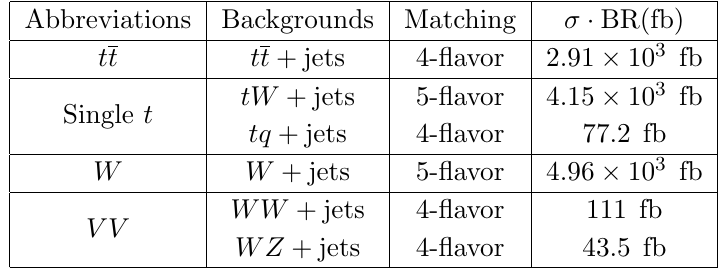
Table 4 . The summary of the SM backgrounds after generation level cuts eqs. (6.4){(6.6). Matching refers to the either the 4-(cid:13)avor or 5-(cid:13)avor MLM matching. (cid:27) section (fb) times branching ratios including the top, W , and Z